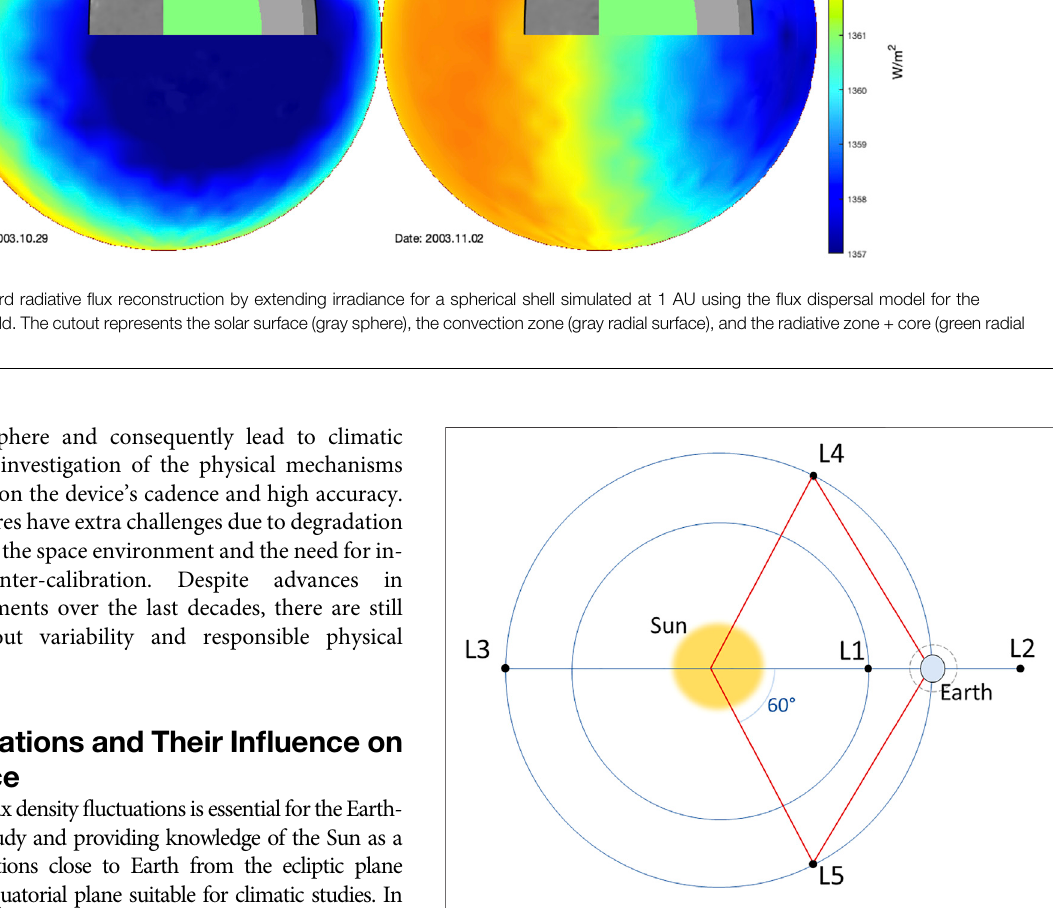
FIGURE4| SchematicoftheSun-EarthmodelwithLagrangepointL1to L5. All instruments have observed the TSI at near-Earth orbits save VIRGO/ SOHO, which operates at